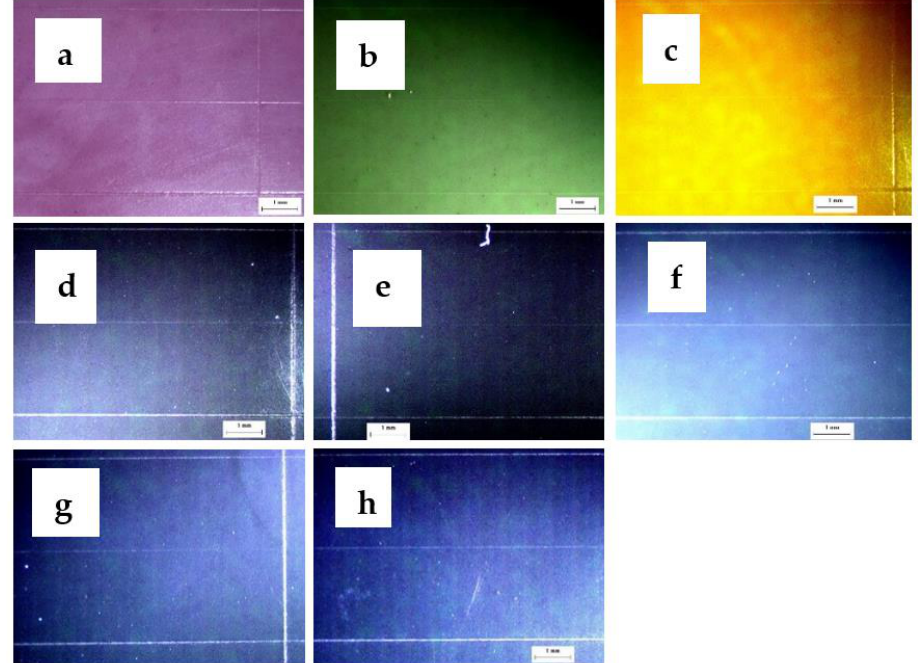
Figure 2. Surface detail reproduction for commercial and Exp VPS (medium-bodied) impression materials under dry conditions, where (a) Aq M, (b) Extr M, (c) Elt M, (d) Exp-I, (e) Exp-II, (f) Exp-III, (g) Exp-IV and (h) Exp-V. The scale bar is 1 mm.